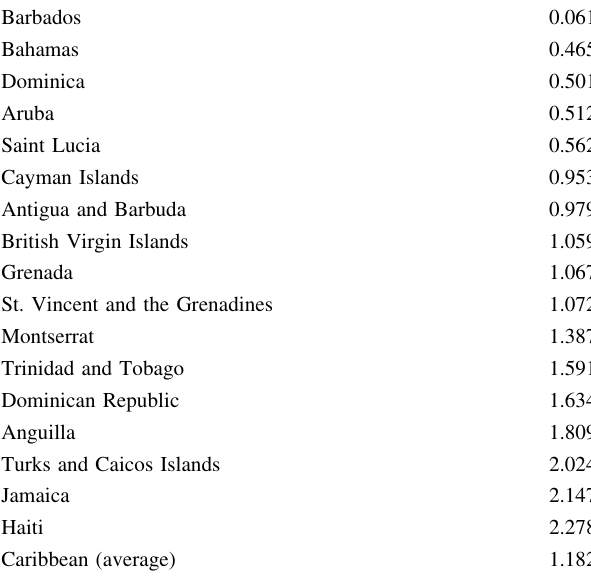
Table 3 Inefficiency scores by country in the